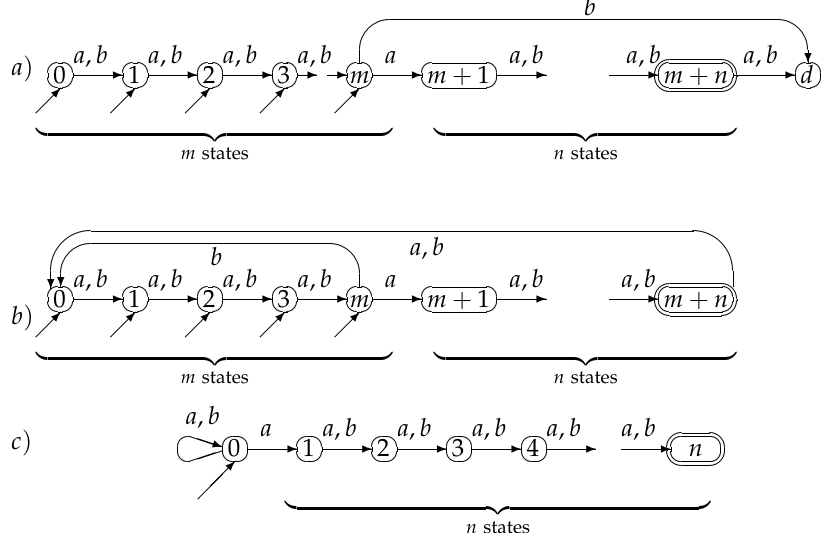
Figure 4. Example of m -DFA having m + n + 2 states for L m , n − 1 ( a ), the corresponding m -DFCA ( b ), and the corresponding NFCA ( c